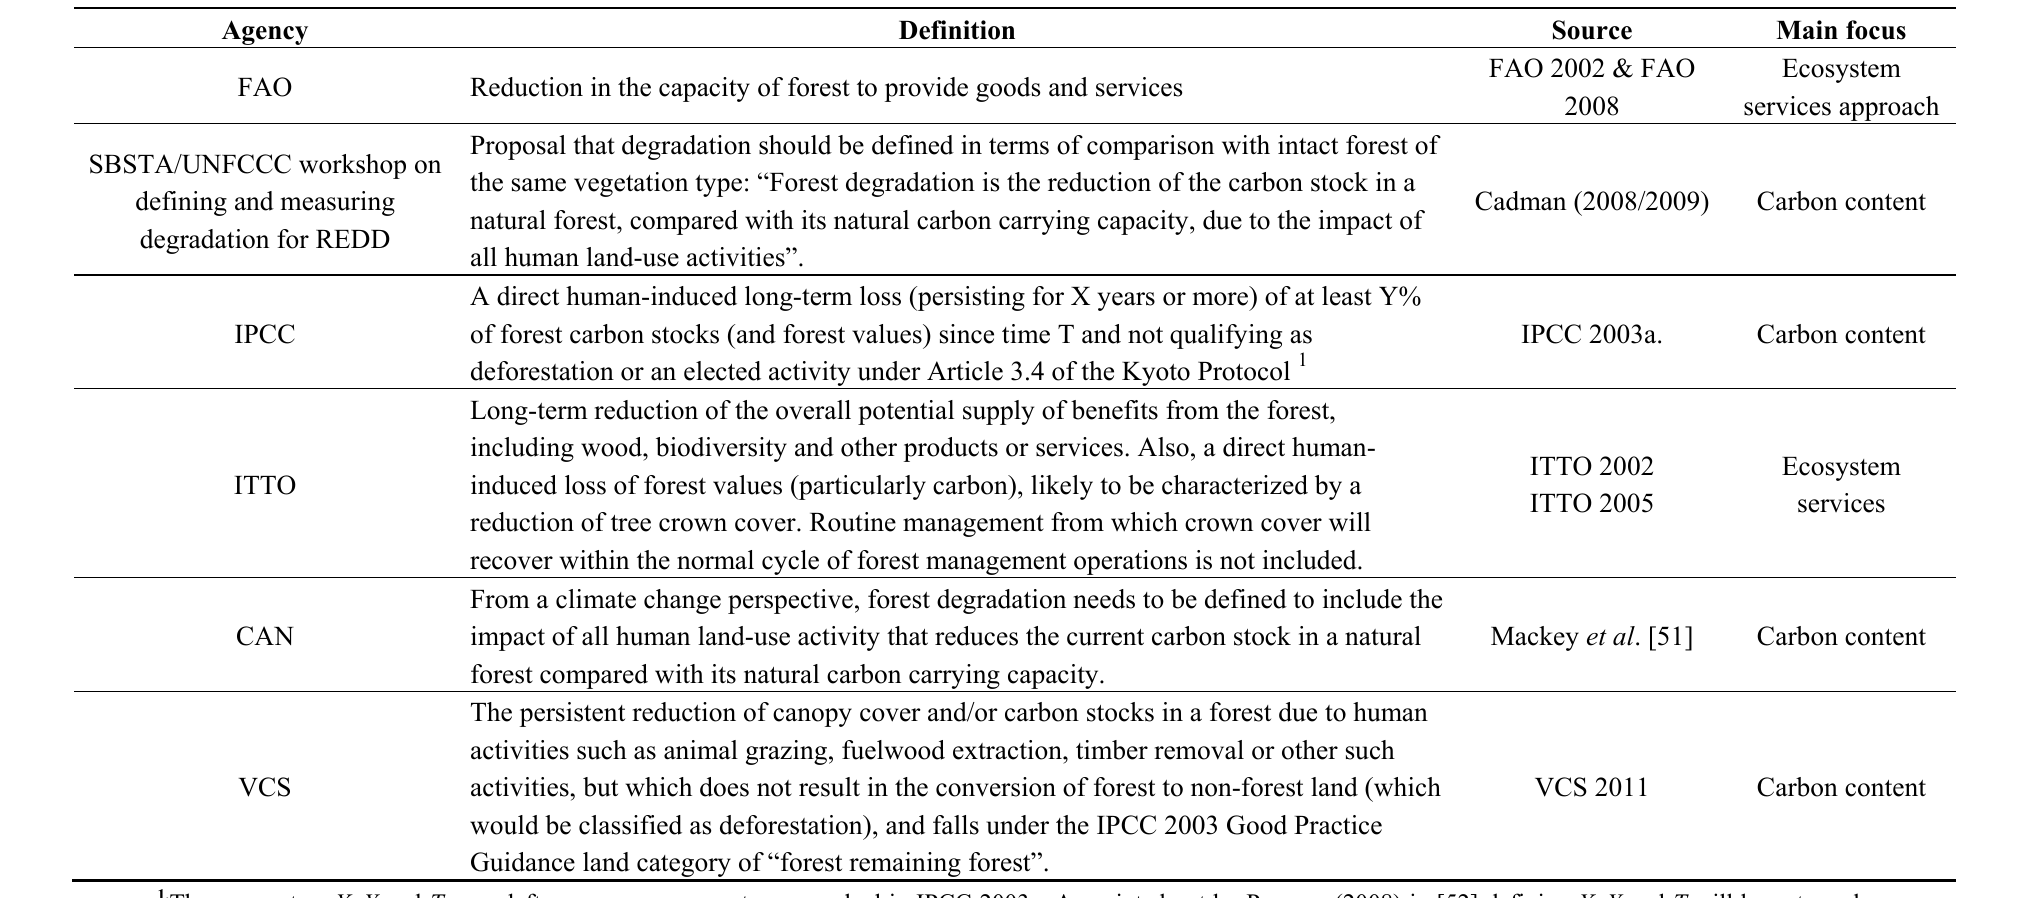
Table 2. Definitions of forest degradation proposed by relevant international policy bodies concerned with